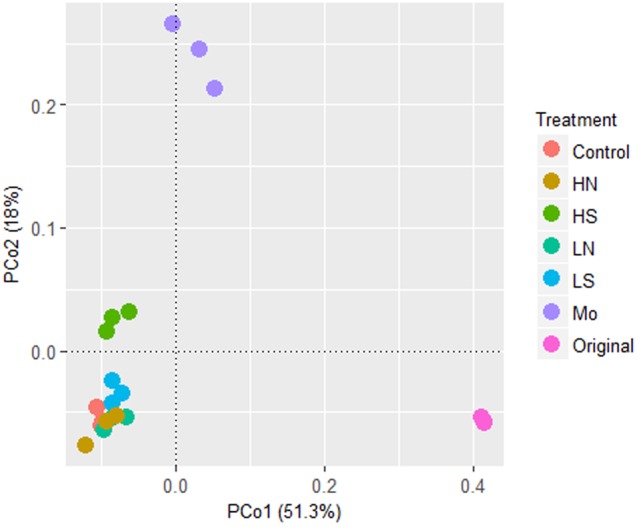
PCoA analysis based on the relative abundances of bacterial pyrotag sequences. Symbols: Control, treatment without addition; HN, 10 mM NaNO3; HS, 20 mM Na2SO4; LN, 5 mM NaNO3; LS, 5 mM Na2SO4; Mo, 20 mM Na2MoO4; Original, the original soil at day 0. Three replicates were conducted among one treatment.